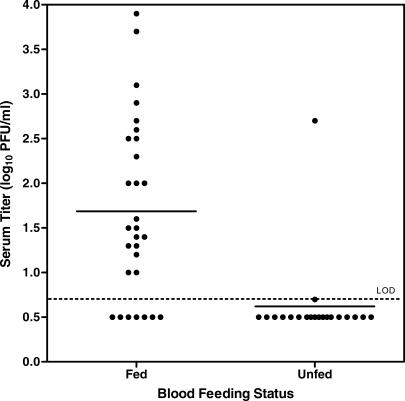
Mosquitoes Inoculate a Small Amount of Virus Intravascularly when Blood FeedingAmount of WNV in the serum of animals following mosquito feeding on distal tissues. Mosquitoes either probed tissue and imbibed blood (Fed) or probed without blood feeding (Unfed). Solid line indicates mean WNV titer in serum of each group. LOD of plaque assay is shown.